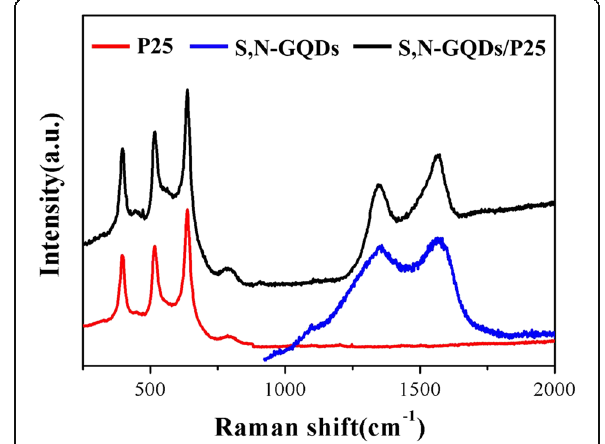
Fig. 4 Raman spectra of P25, S,N-GQDs and